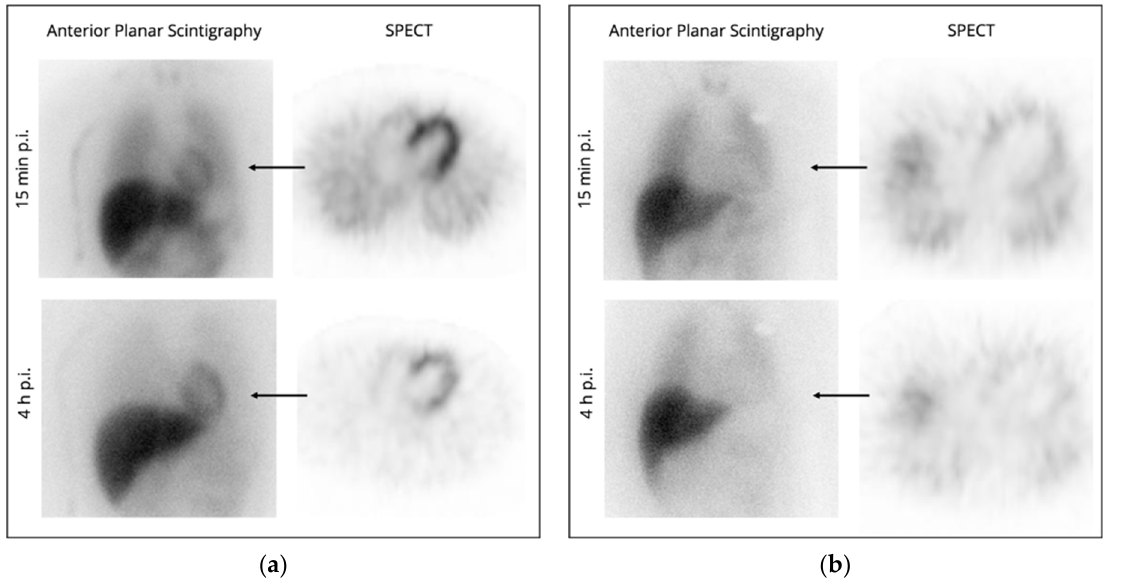
Figure 3. ( a ) Example for a physiological result in 123 I-MIBG imaging: Physiological sympathetic cardiac innervation (HMR late: 2.1, normal range: 2.0–2.4; physiological washout of 14%). ( b ) Example for a pathologic result: Decreased sympathetic cardiac innervation (HMR late: 1.3; increased washout of 28%). HMR: heart-to-mediastinum ratio. Images were acquired at our institution.